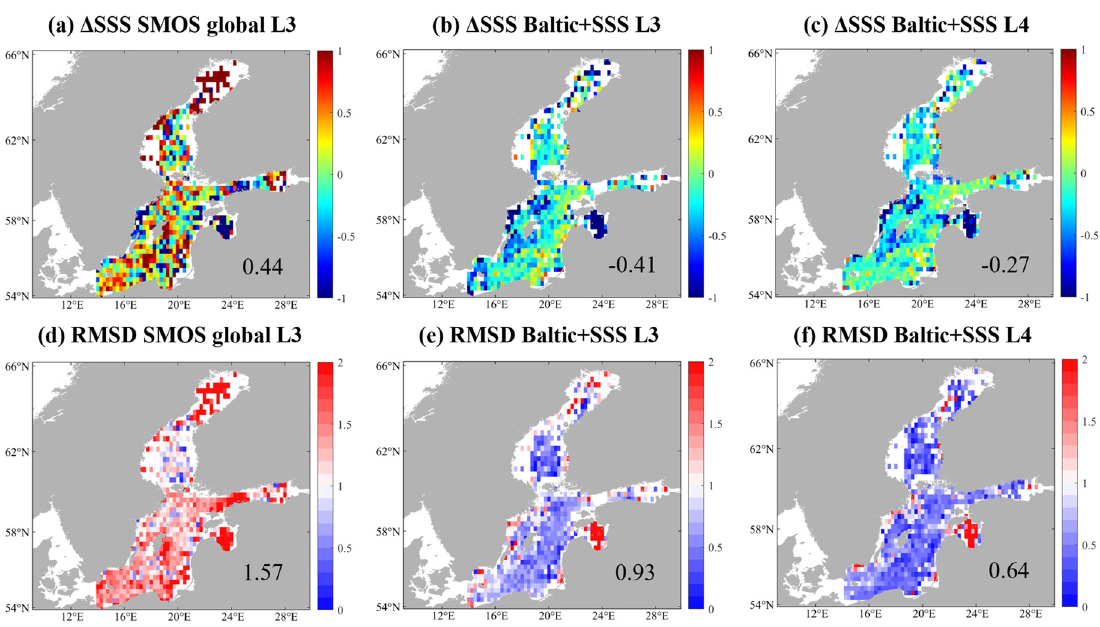
Figure 4. Horizontal distribution of mean Δ SSS (upper) and RMSD (bottom) values with respect to in situ SSS measurements. From left to right: BEC global L3 product, Baltic+SSS L3 product and Baltic+SSS L4 product. The numbers labeled in the lowest right are the spatial average RMSD values. The unit is in PSU.